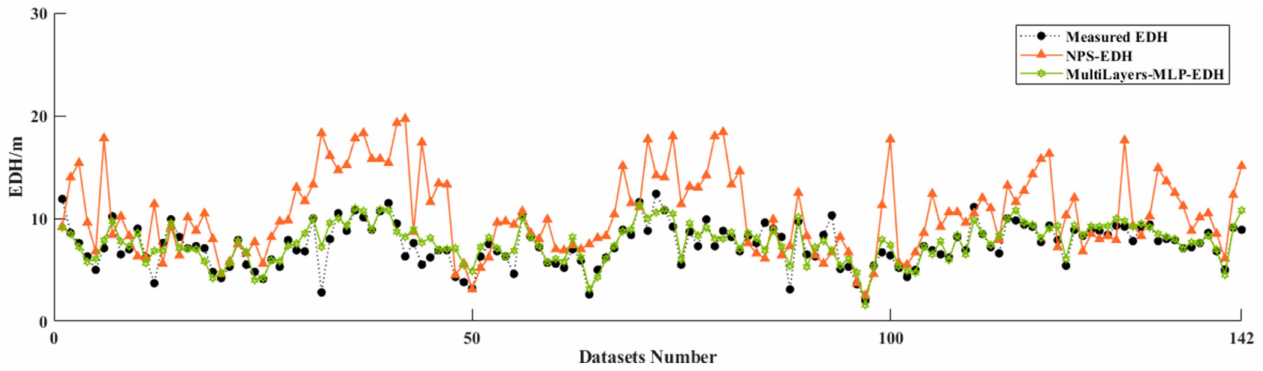
Figure 8. Generalization performance of the multilayer-MLP-EDH